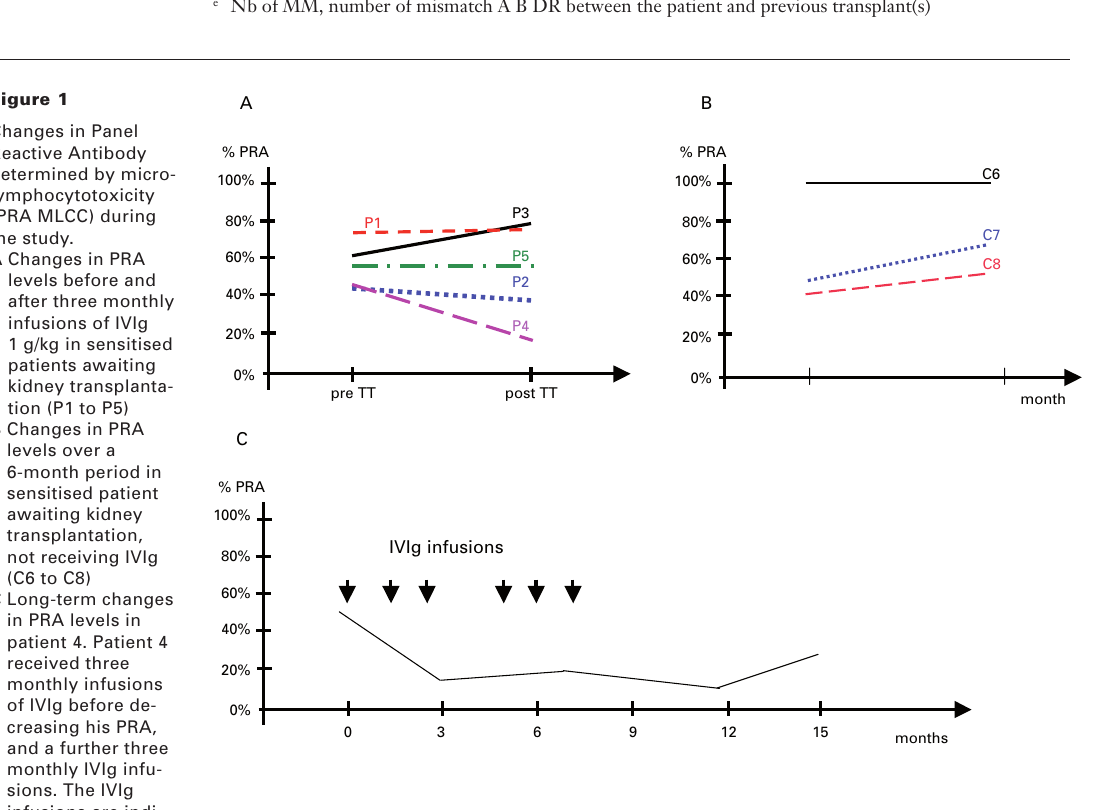
Figure 1 Changes in Panel Reactive Antibody determined by micro-